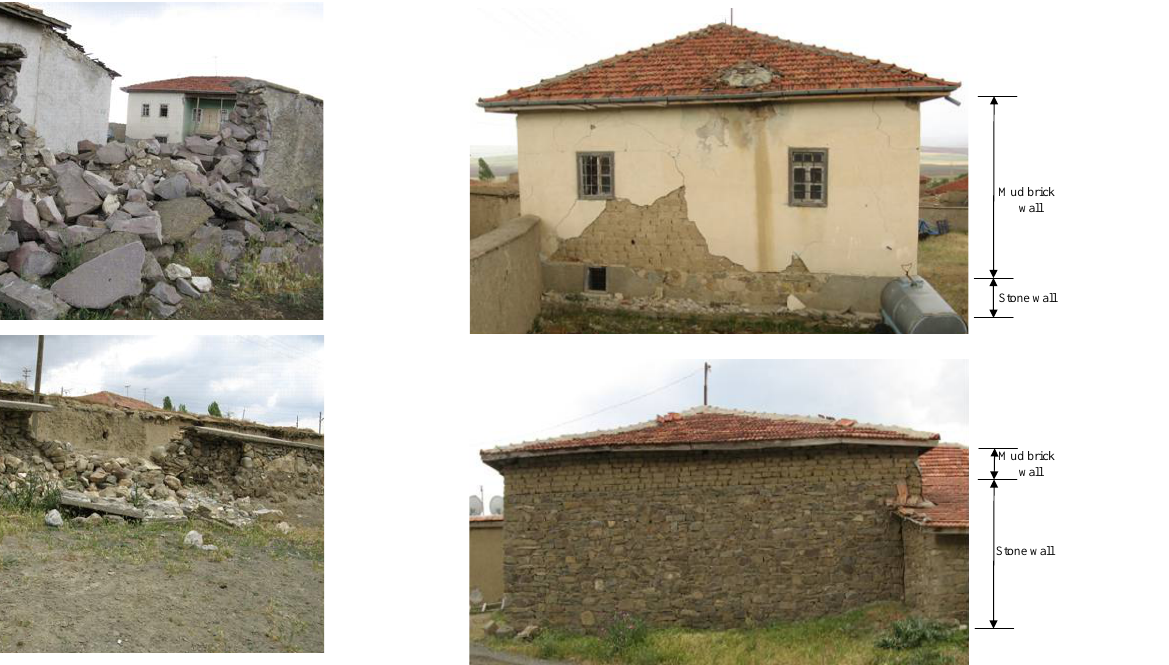
Fig. 21. Examples of mixed type masonry buildings formed by stones and mud bricks. Fig. 21 Examples of mixed type masonry buildings formed by stones and mud bricks